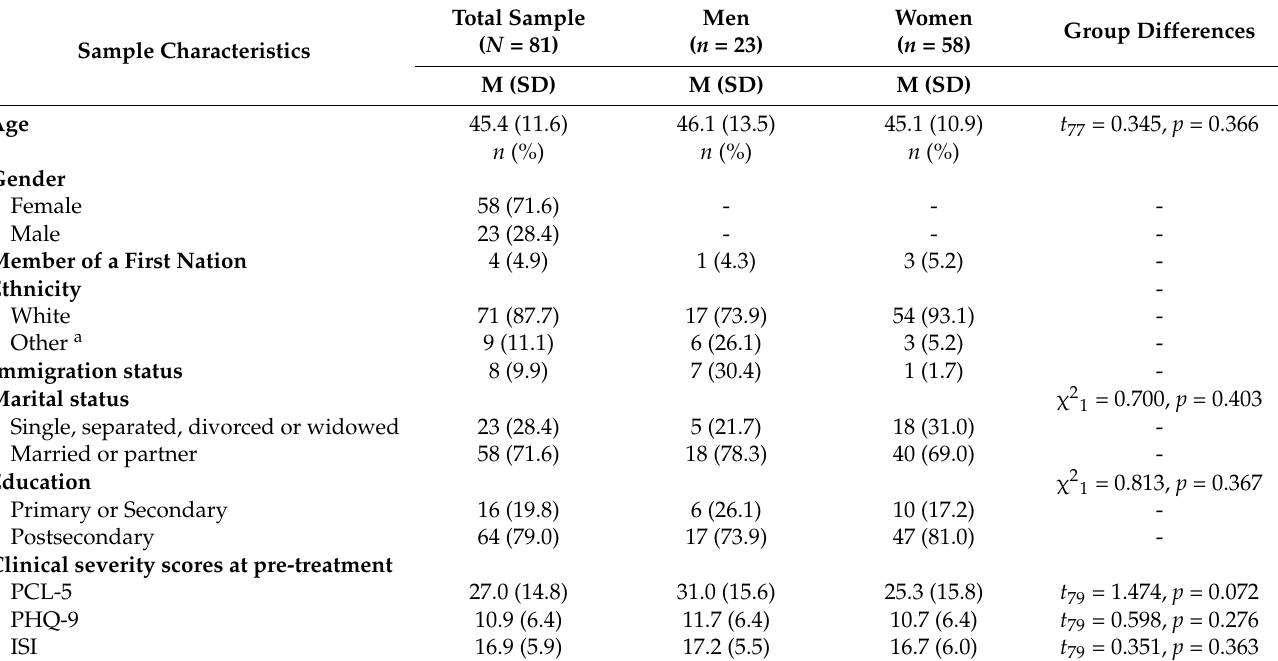
Table 2. Sociodemographic and clinical characteristics of